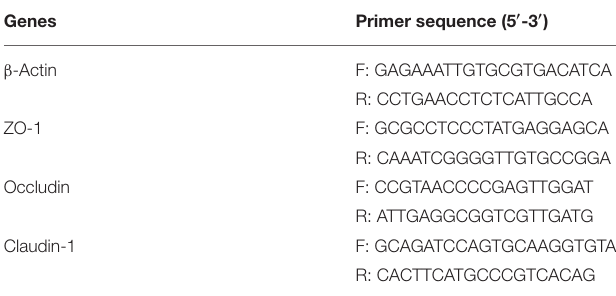
TABLE 2 | Primer sequences used for real-time quantitative